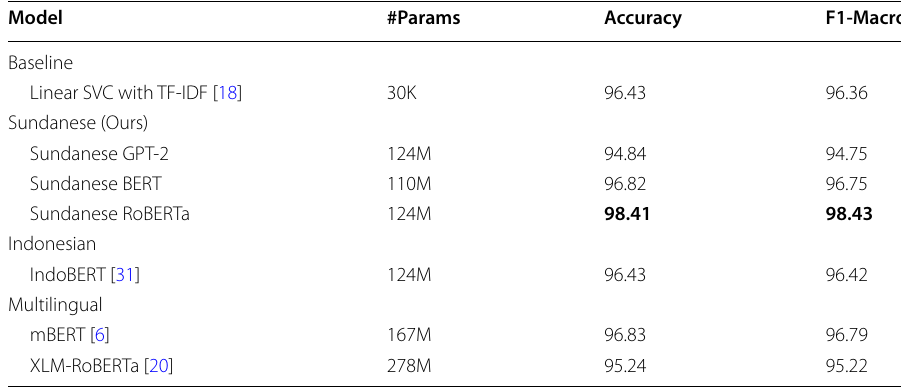
Table 5 Evaluation result of Sundanese Twitter emotion classification